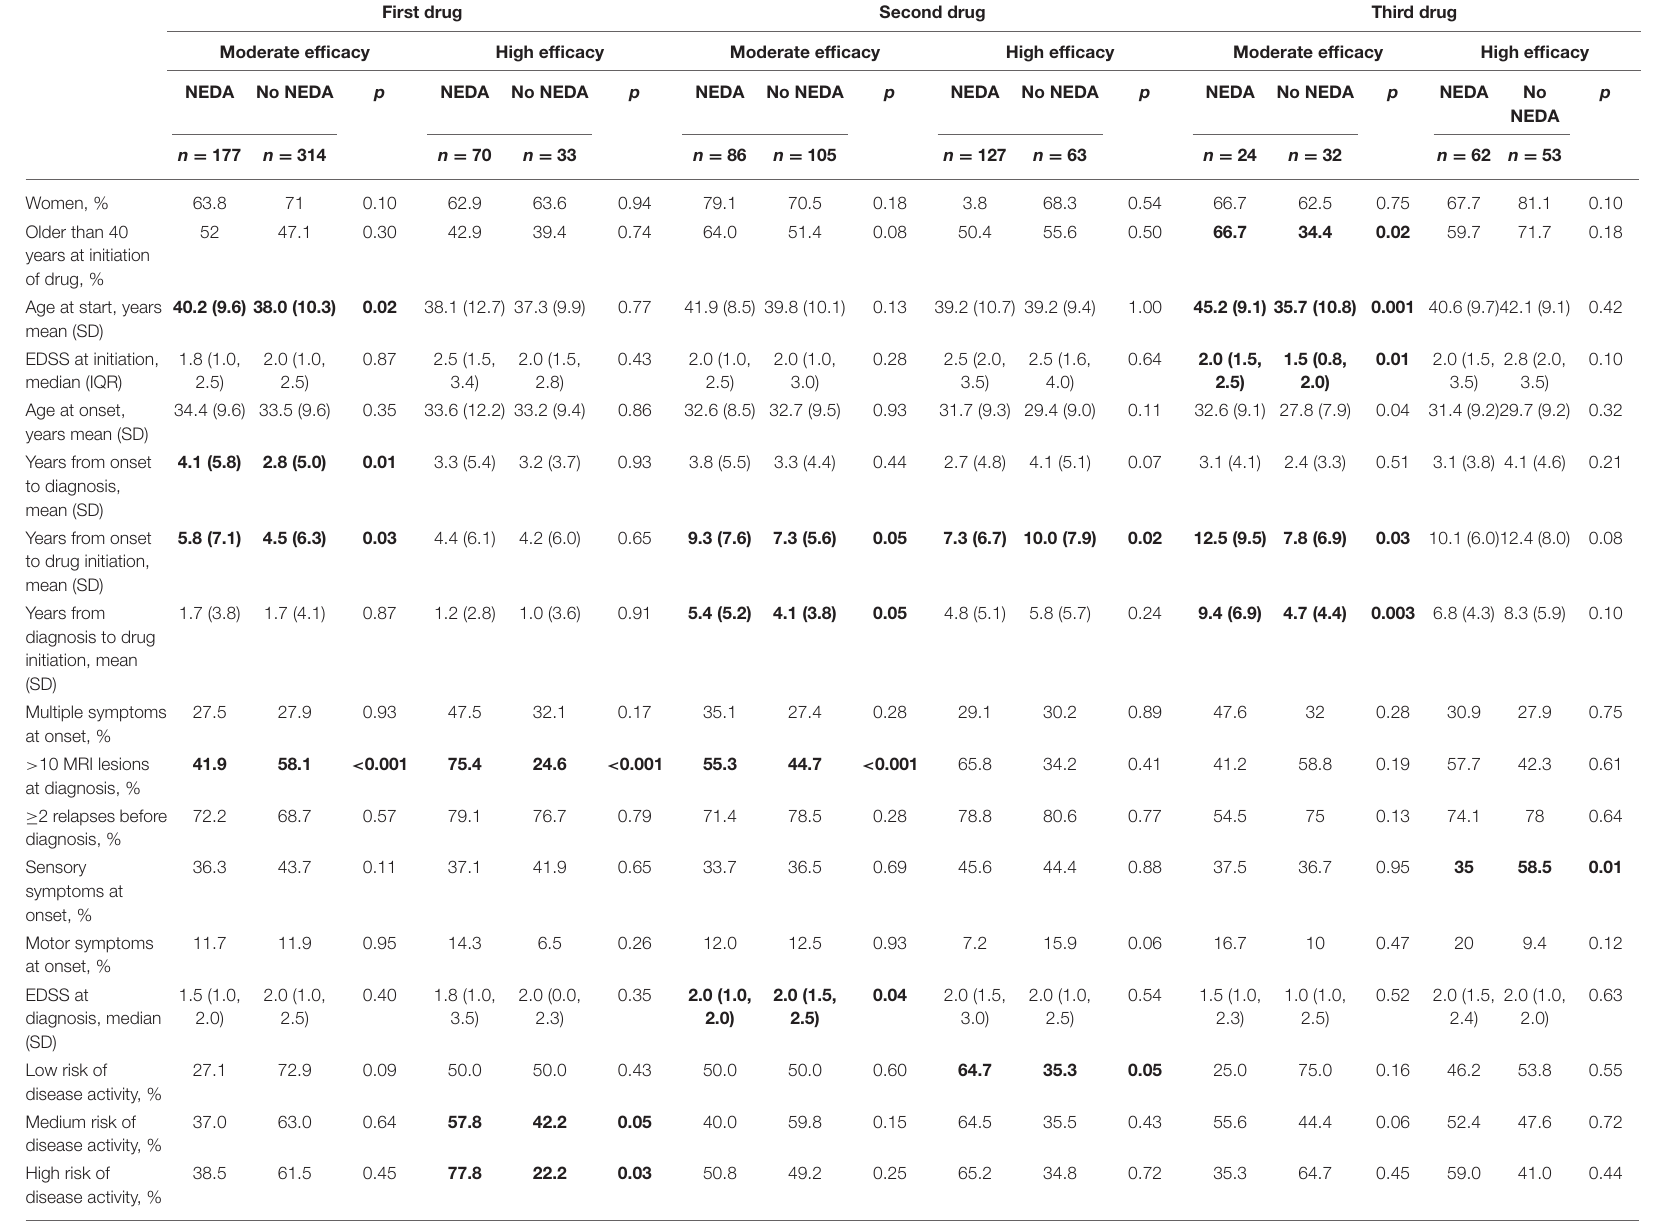
TABLE 6 | Demographics by NEDA and no